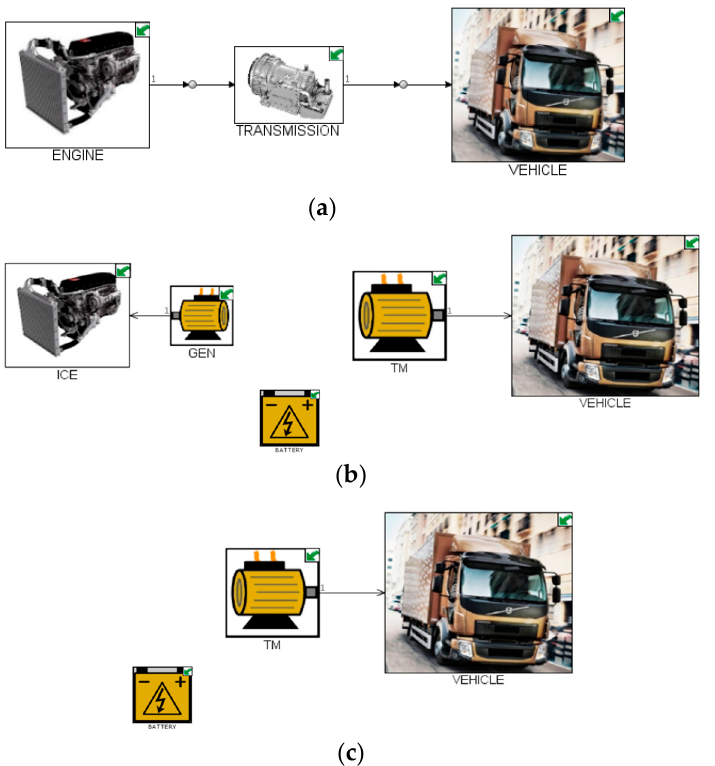
Figure 2. GT-Suite model layout of the nonhybrid ( a ), plug-in hybrid ( b ), and pure electric truck ( c ).